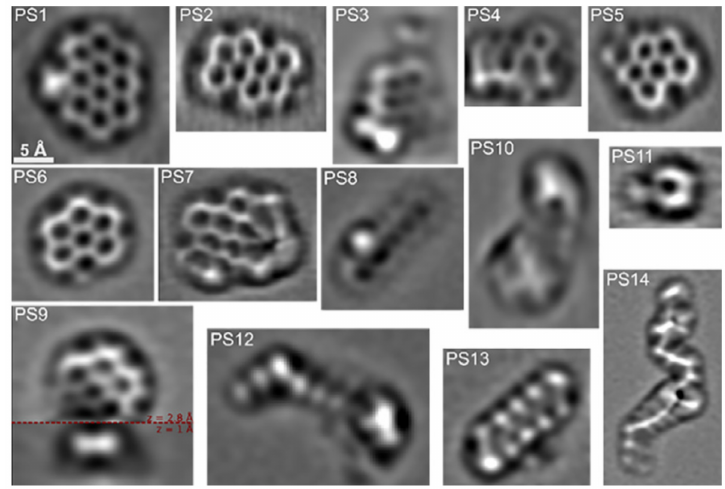
Figure 1. Laplacian-filtered AFM images of identified PAH molecules and aliphatic chains/ substituted benzenes found in the soot particles collected at Z = 14 mm burner-to-probe separation distance (primary soot particles) [17]. All images from PS1 to PS14 have the same